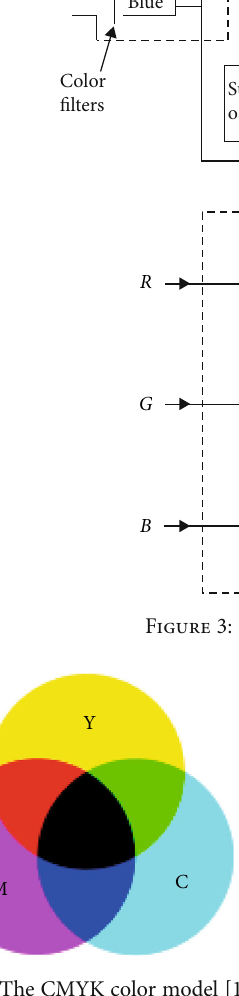
Figure 4: The CMYK color model [16].